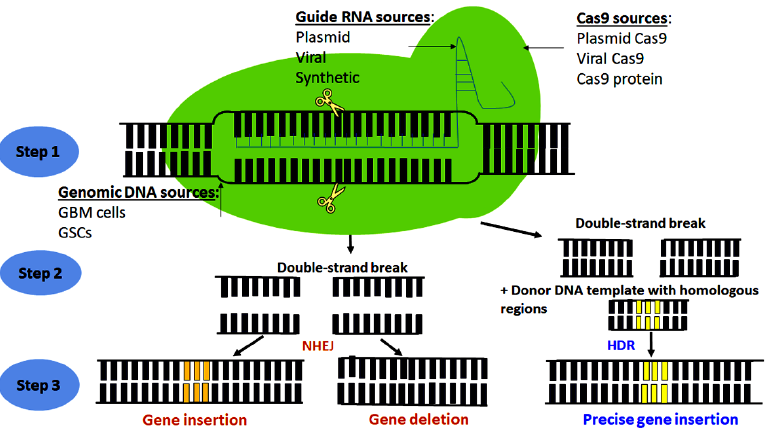
Figure 1. Principle of CRISPR-Cas9 genome editing and sources of its major elements for application to GBM research. CRISPR-Cas9 genome editing involves three major steps: Step 1, guide RNA binds to complementary sequence in the gene of interest; Step 2, Cas9 performs double-strand DNA break; Step 3, activation of non-homologous end joining (NHEJ) mechanism repairs DNA by directly ligating double-strand DNA break ends after DNA sequences are inserted or deleted, or activation of homology-directed repair (HDR) mechanism inserts the targeted DNA sequence in the presence of donor DNA template with homology regions to the cut-ends resulting in more precise gene insertion. Majority of CRISPR-Cas9 genome editing applications were performed in GBM cell lines or